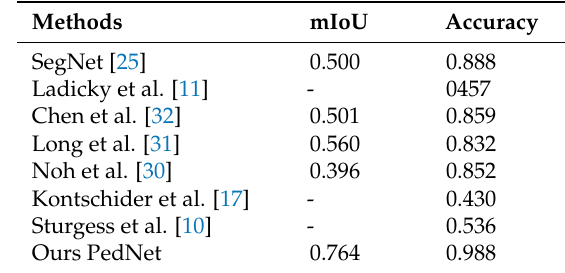
Table 3. Quantitative results of our PedNet against state-of-the-art methods on CamVid dataset. The results of [10,11,17] are based on hand-crafted features. The results of [25,30–32] are based on deep model. It is apparent that the deep model outperforms the classical approaches and our PedNet outperformed the deep models by a good